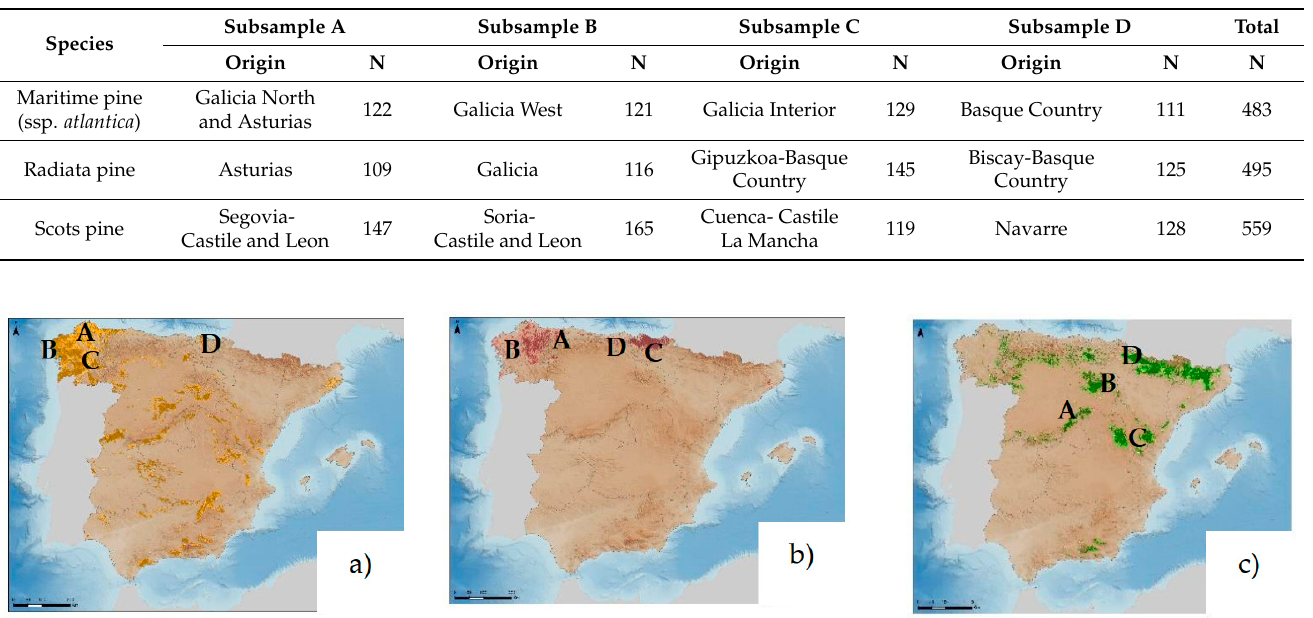
Table 1. Subsamples origin and number of specimens (size).